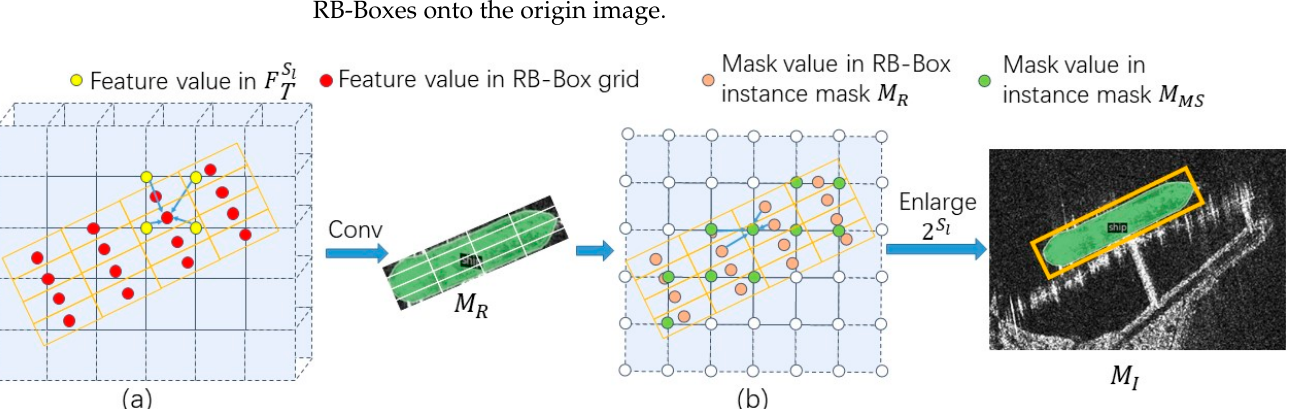
Figure 6. Overviews of the DetHead ( a ) and the MaskHead ( b ). In ( a ), and